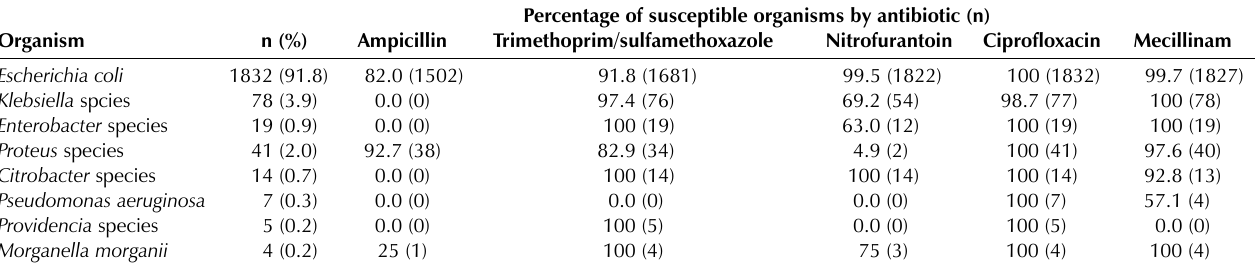
In vitro susceptibility of community Gram-negative uropathogens to selected antimicrobial agents Percentage of susceptible organisms by antibiotic (n) Organism n (%)